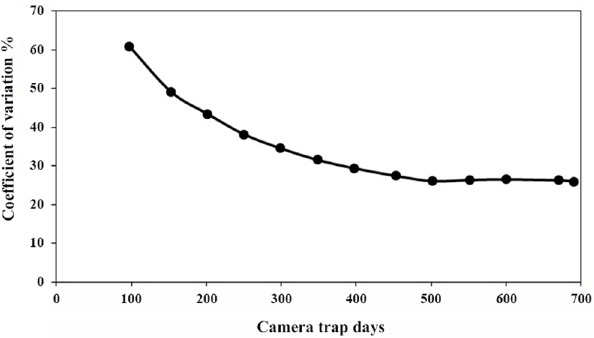
Fig 2. Camera trapping sampling precision for S . blouchi . Sampling precision was expressed as CV of S . blouchi camera trap rate with cumulative sampling effort (number of camera trap days) in the protected